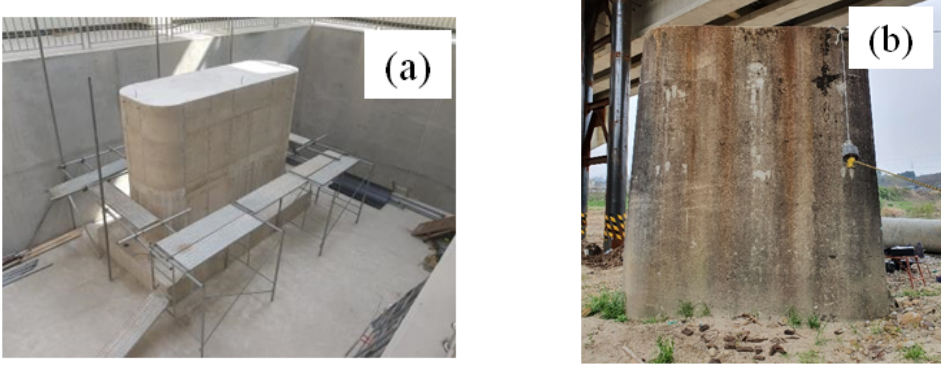
Figure 2. Target pier for the impact load test. ( a ) Full-scale model pier and ( b ) field bridge pier.